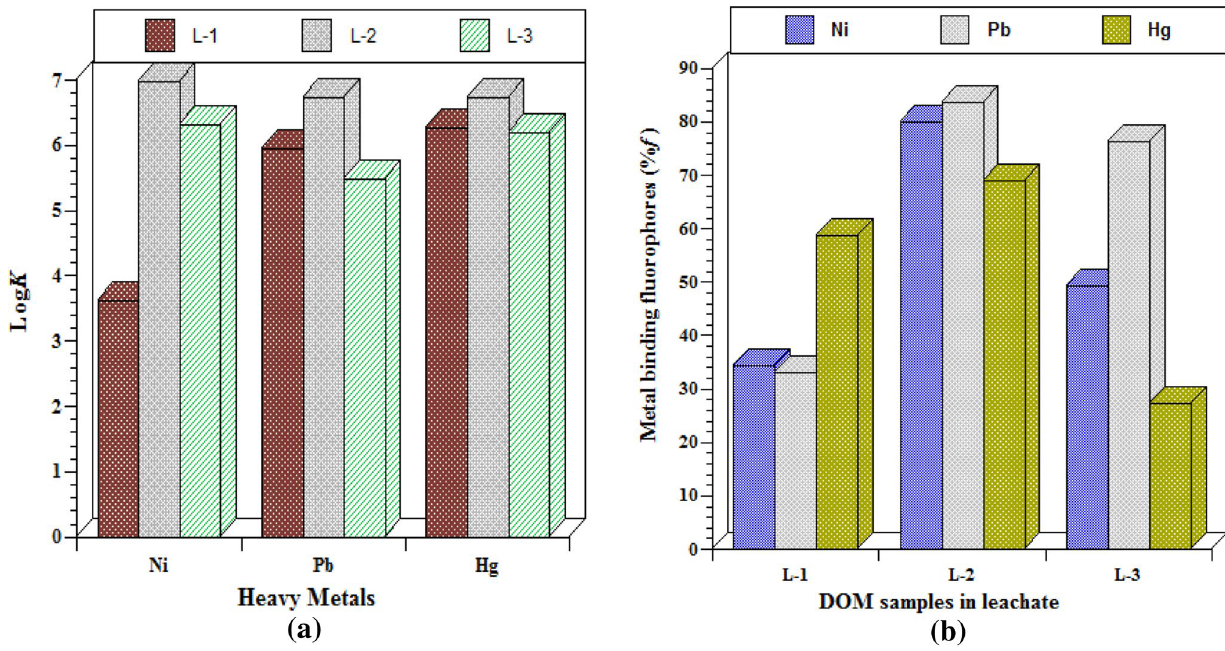
Fig. 3 a Stability constant (Log K ) of L-1, L-2 and L-3 with Ni 2+ , Pb 2+ and Hg 2+ . b Percentage of toxic metal binding fluorophores in DOM